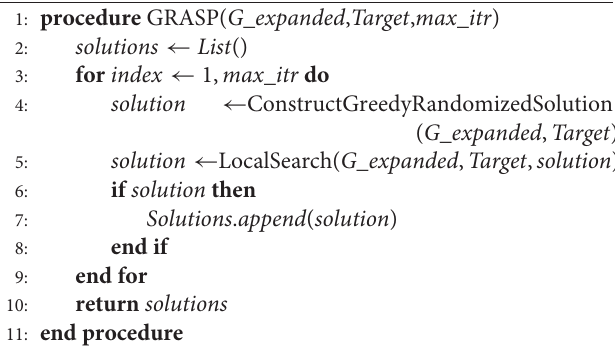
Algorithm 1 GRASP algorithm for Target Control Problem